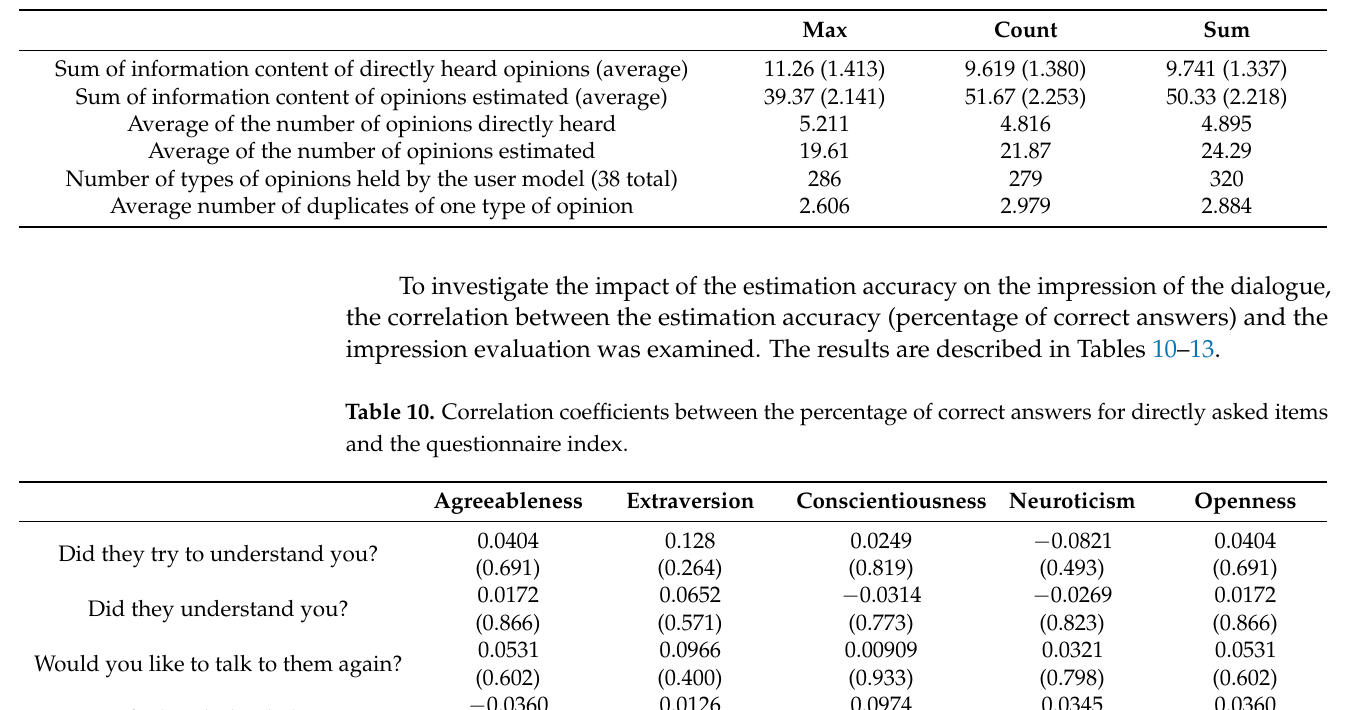
Table 9. Parameters after dialogue.